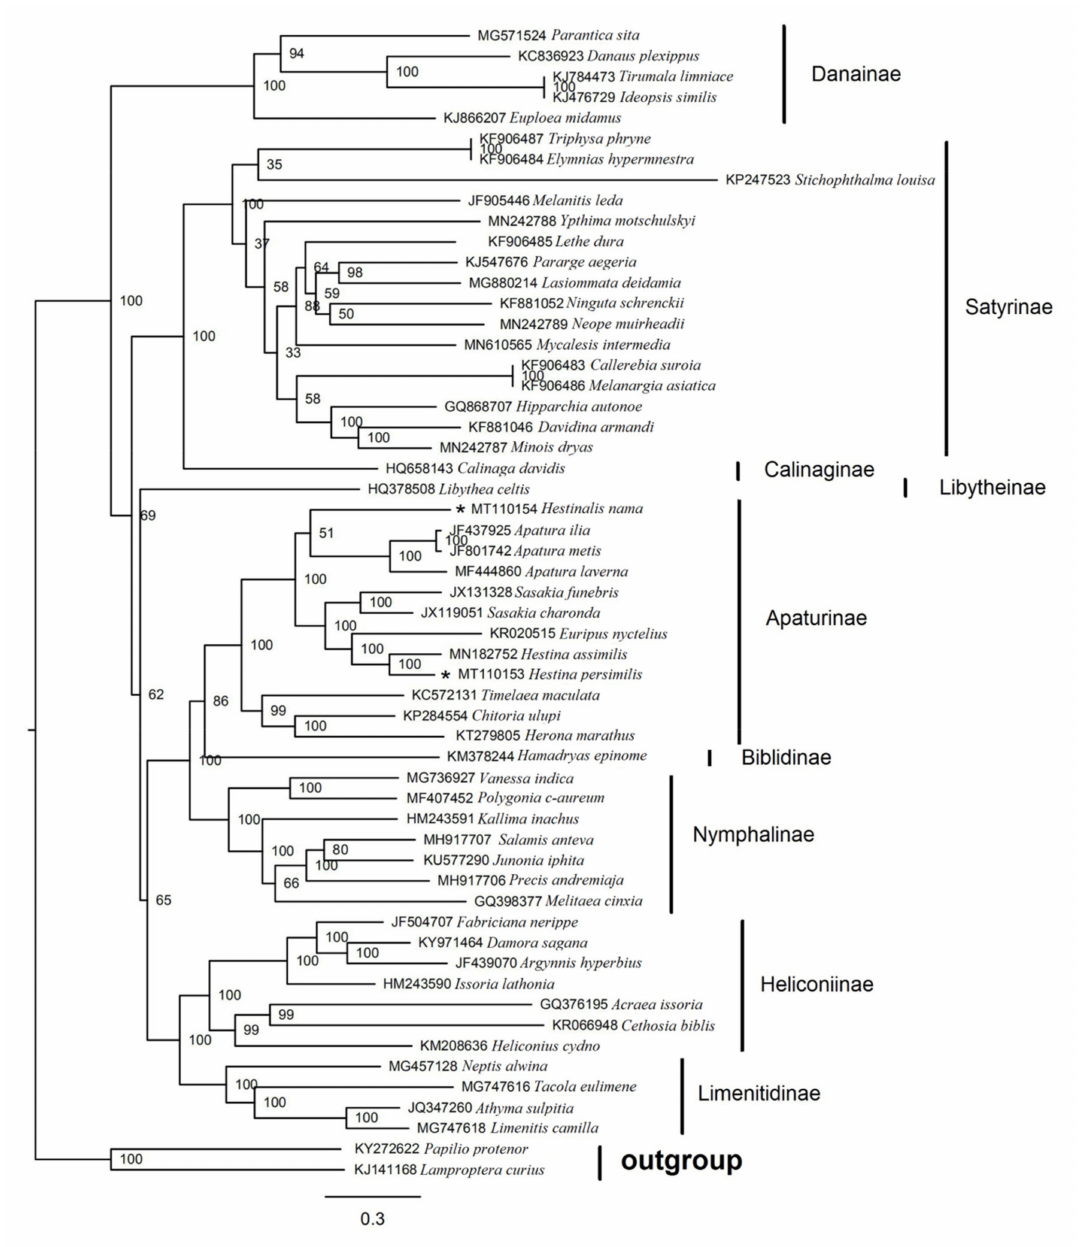
Figure 12. Inferred phylogenetic relationships among Lepidoptera based on the concatenated nucleotide sequences of 13PCGs using ML. Numbers on branches are bootstrap percentages. Papilio protenor (KY272622) and Lamproptera curius (KJ141168) are used as